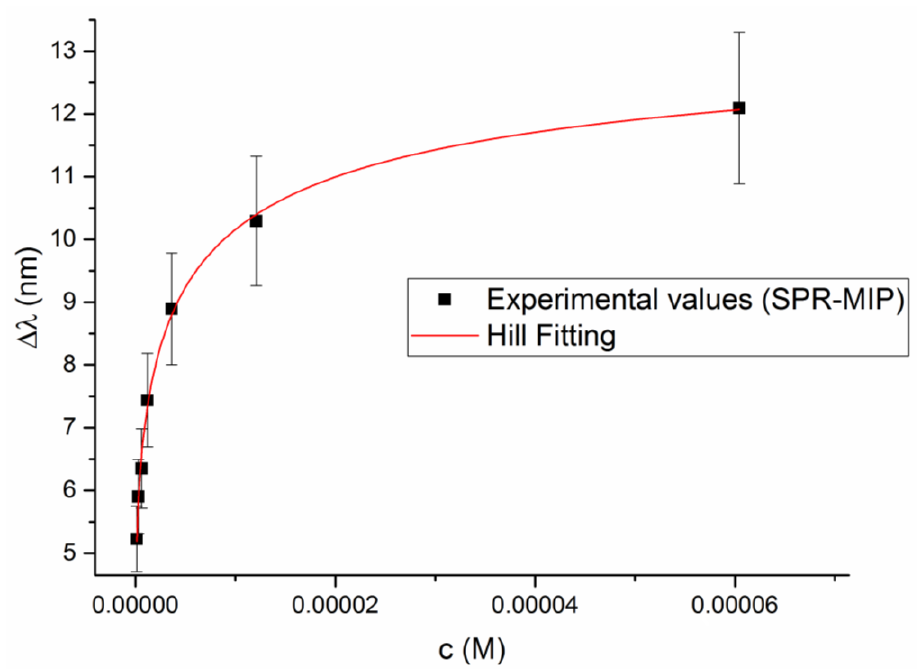
Figure 8. Sorption isotherm of 2-FAL on MIP, obtained from the resonance wavelength shift observed in Figure 7.